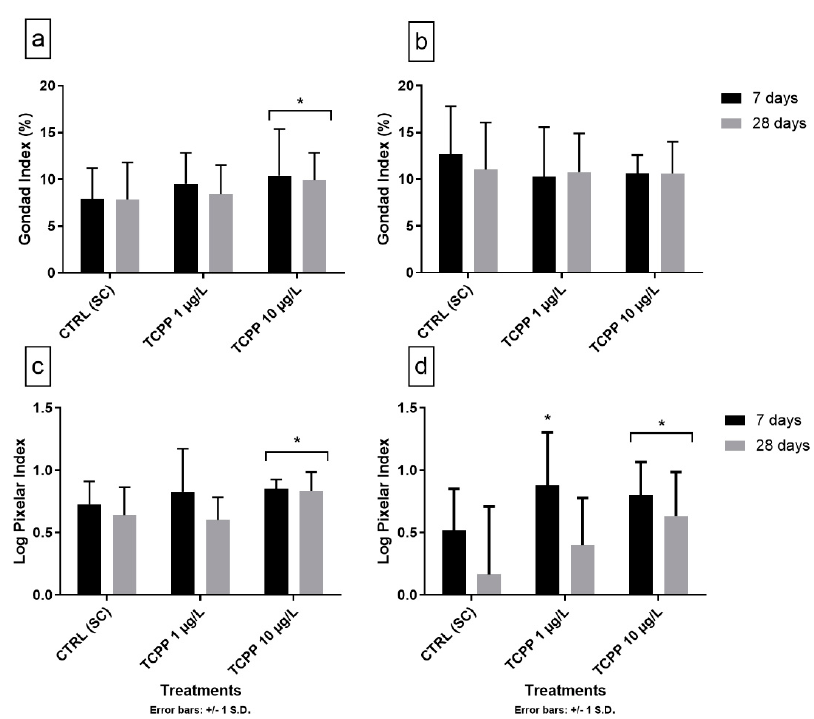
Figure 3. Gonad Index ( a , b ) and Pixelar Index ( c , d ) (mean ± SD) of female ( a , c ) and male ( b , d ) P. lividus sea urchins exposed for 7-d (black bars) and 28-d (grey bars) to tris (1-chloro-2-propyl) phosphate (TCPP) in 2016 (n = 7–17). Asterisks indicate significant ( P < 0.05) differences with respect to solvent control (CTRL (SC)).